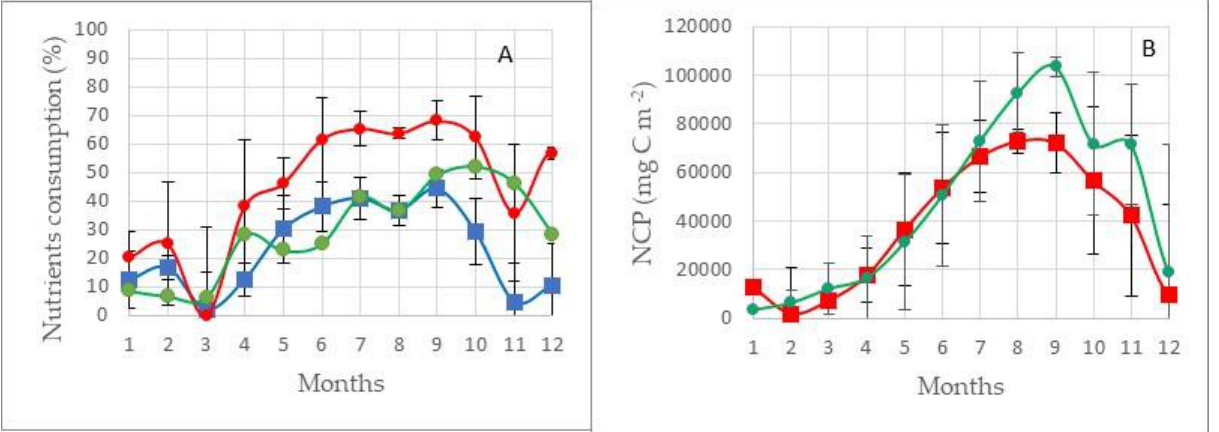
Figure 9. Annual cycle of primary production and nutrient consumption ( A ) and primary produc- tion ( B ) in Region II; ( A ) is the consumed part of the nutrient supply in the process of photosynthesis (blue: mineral phosphorus, red: mineral nitrogen, green: silicon); ( B ) primary production (green: NCP Si ; red: NCP N ).